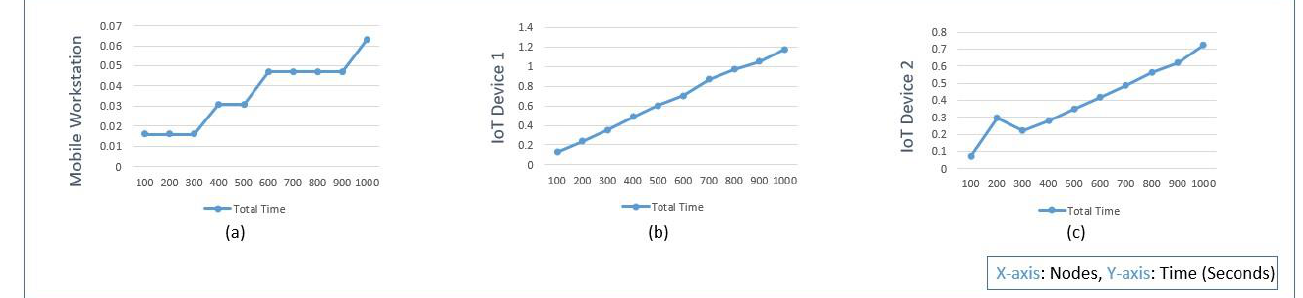
Figure 7. Protocol total time analysis and comparison within the ( a ) mobile workstation, ( b ) IoT device 1, and ( c ) IoT device 2.